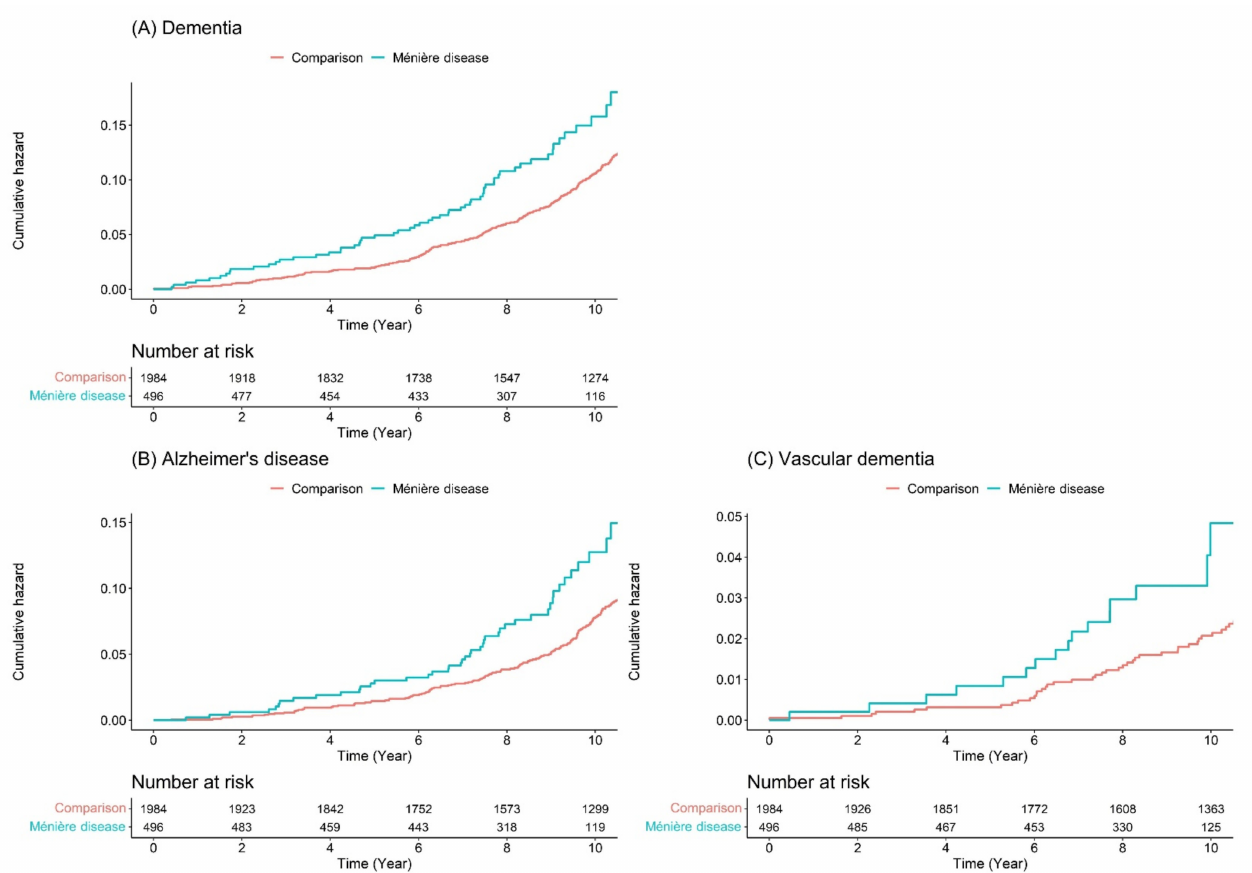
Figure 3. Cumulative hazard plot of dementia between the M é ni è re’s disease group and the compari- son group. ( A ) All cause of dementia; ( B ) Alzheimer’s disease; ( C ) vascular dementia.